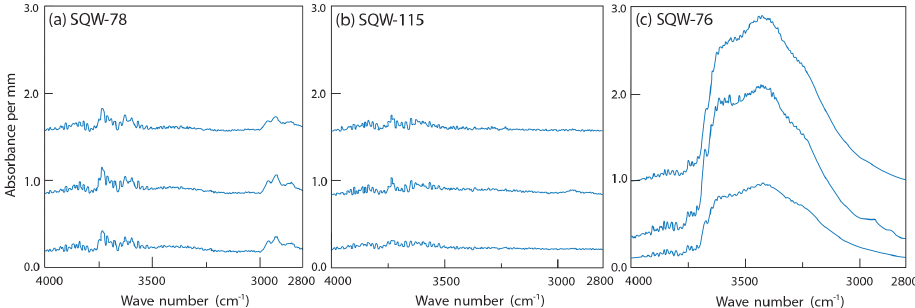
Figure 7. Representative IR spectra for plagioclase in the xenolith samples, with measured absorbances normalized to 1mm sample thickness.